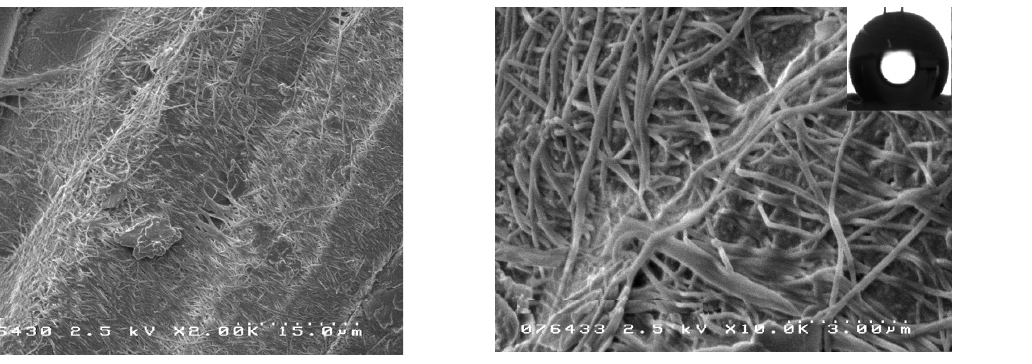
Figure 4. SEMs of composite prepared by impregnation of gelator 7a on Kolon® fabric at 2,000× (left) and 10,000× (right)